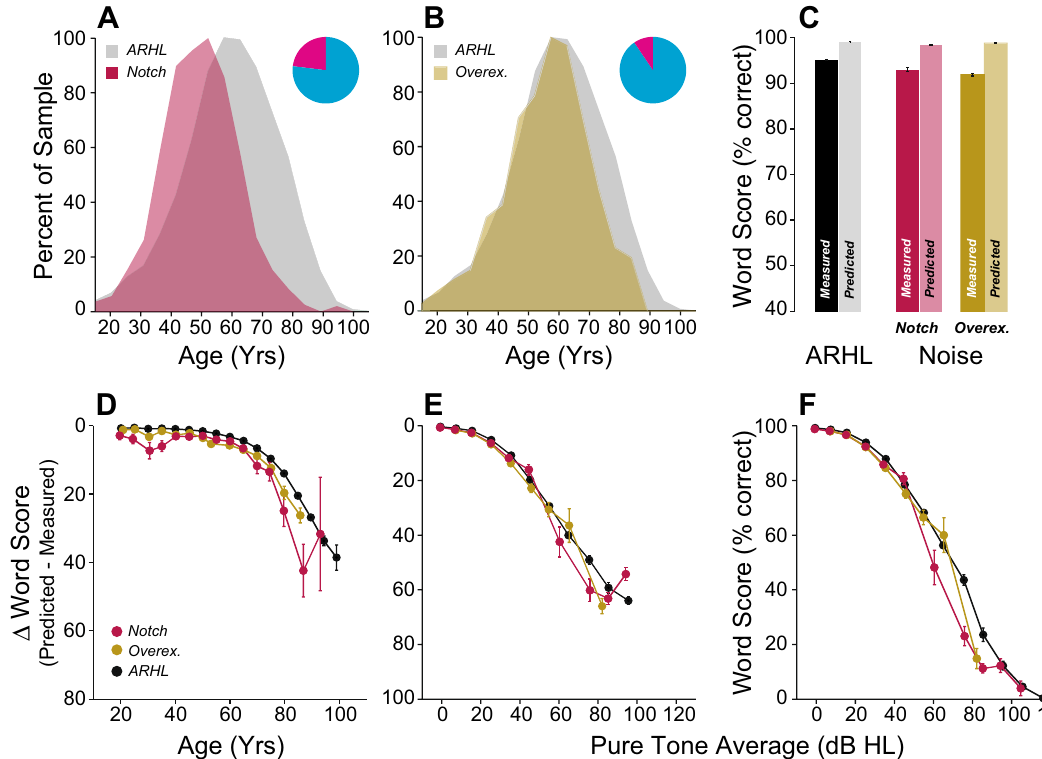
Figure 13. Intelligibility deficits in patients with inferred acoustic overexposure. ( A , B ) Age distribution of patients presenting with a 4-kHz audiometric notch (Notch, A ) or reporting a history of occupational and/ or recreational noise overexposure (Overex., B ). Pie charts indicate the proportion of male (cyan) vs. female (magenta) for each group. ( C ) Comparison of mean WRS as measured in patients with inferred acoustic overexposure or predicted by the speech intelligibility curve. Scores were compared with patients presenting ARHL. ( D – F ) Speech Intelligibility deficits as a function of age ( D ) or pure-tone average ( E , F ). Legend in ( D ) applies to ( E , F